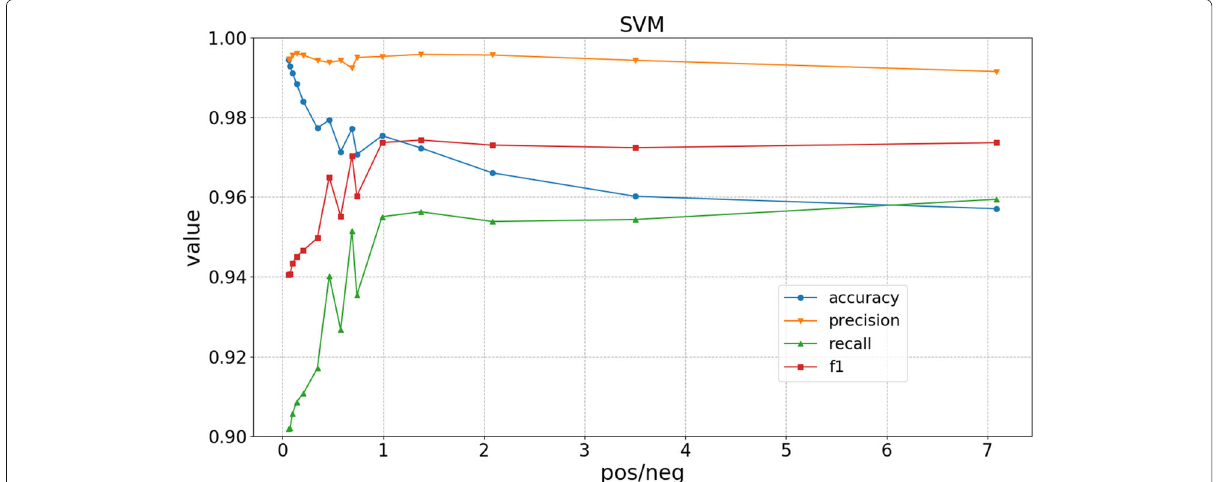
Fig. 7 Result of SVM with different ratios of positive/negative samples. We tested the Support-vector-machine classifiers using the following positive/negative ratios: 7.089, 3.499, 2.081, 1.375, 0.988, 0.727, 0.462, 0.346, 0.278, 0.139, 0.099, 0.075, and 0.058